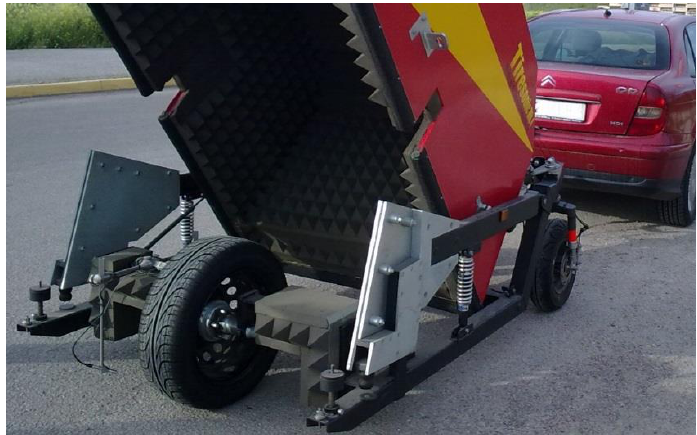
Figure 2. Reference tire inside the semi-anechoic chamber, and rear microphone.